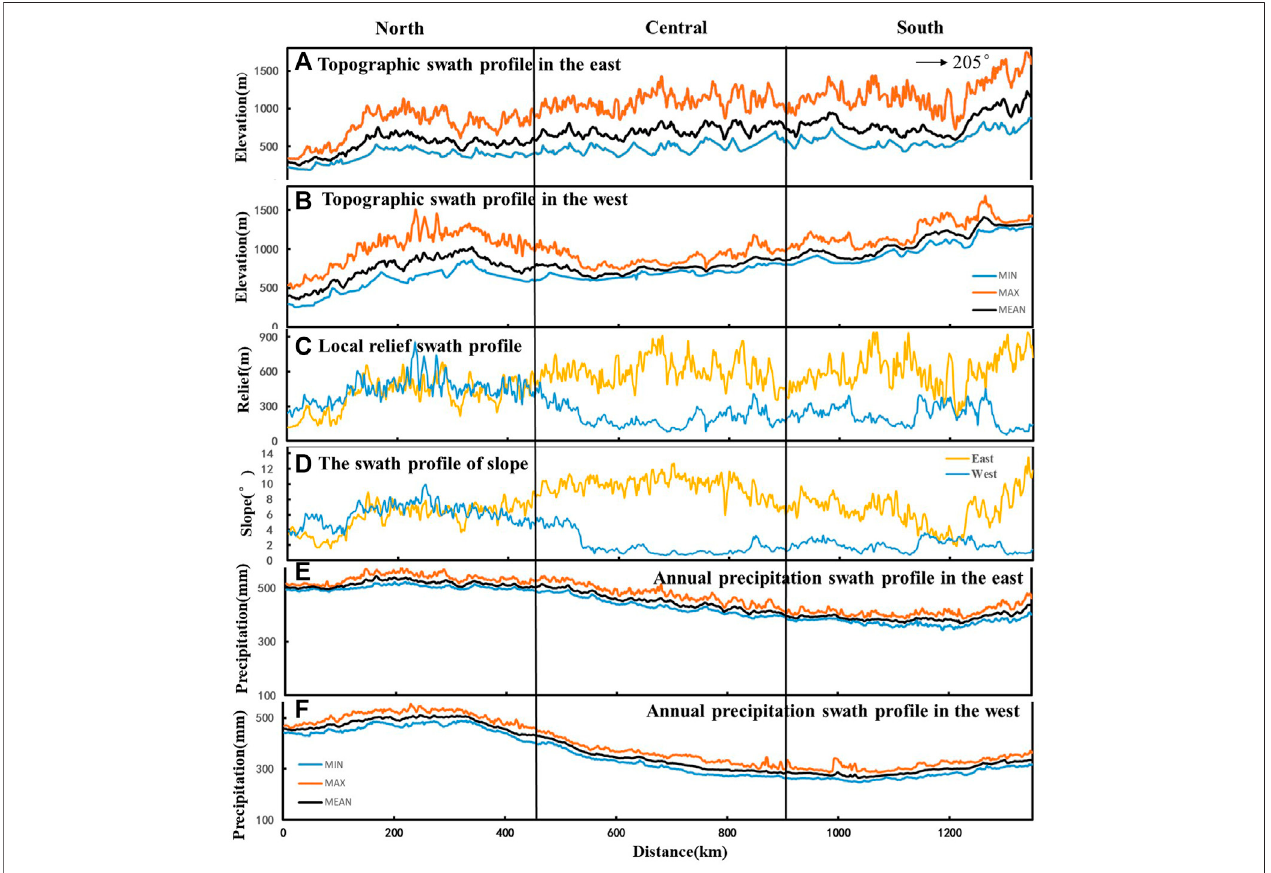
FIGURE9| Theswathpro fi leintheeastoftheGreaterKhinganMountains (A) .Theswathpro fi leinthewestoftheGreaterKhinganMountains (B) .Theswathpro fi le oflocaltopographicreliefintheGreaterKhinganMountains (C) .Theswathpro fi leoftheslopeintheGreaterKhinganMountains (D) .Theswathpro fi le ofaverageannual rainfall in the east of the Greater Khingan Mountains (E) . The swath pro fi le of average annual rainfall in the west of the Greater Khingan Mountains (F) .